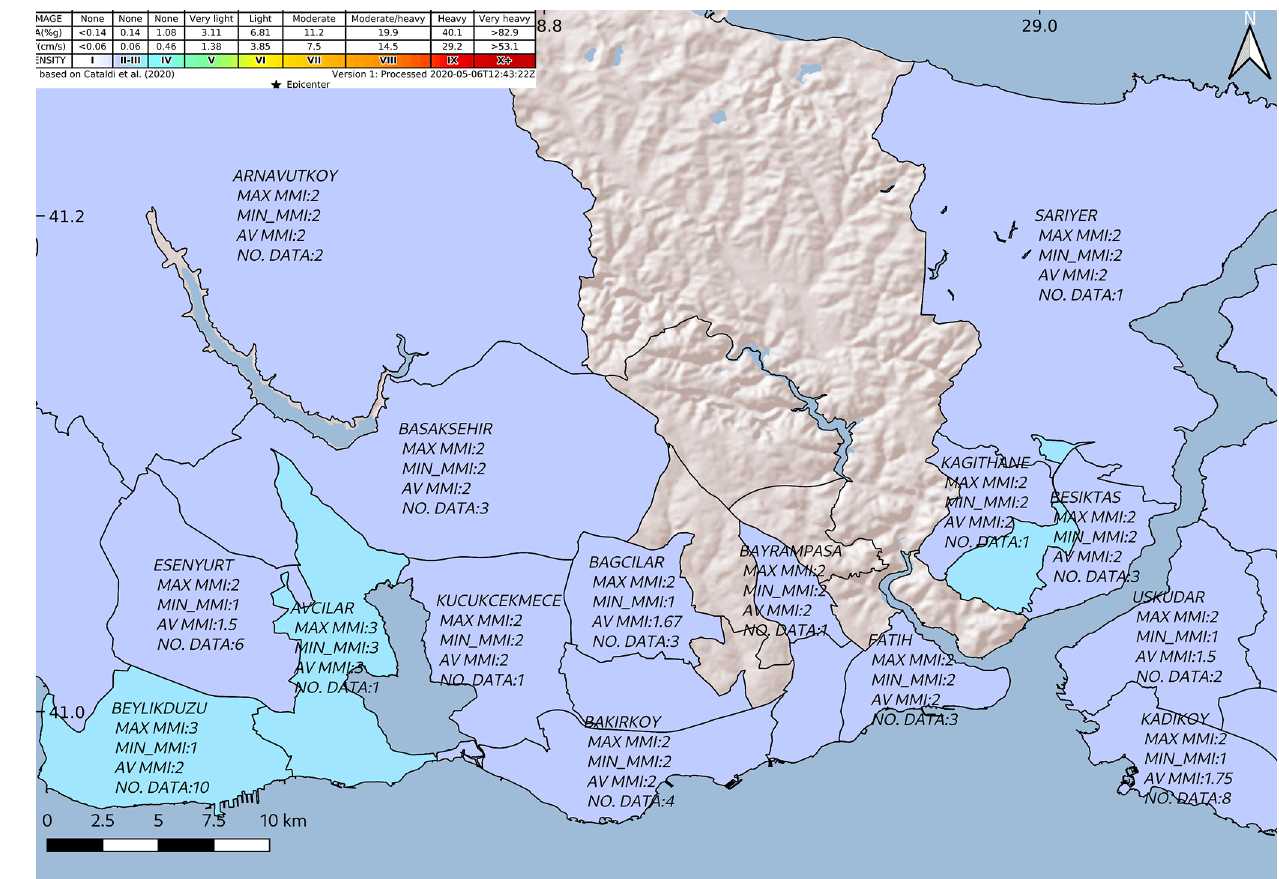
Figure 2. Intensity map of 12 June 2017 Lesbos earthquake with labeled entries on the western side of Istanbul. Entries are plotted to district level polygons (created using